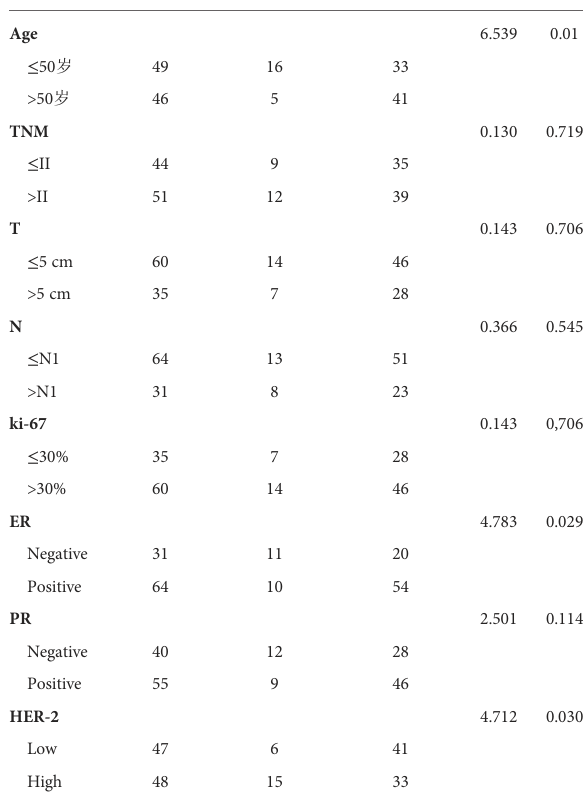
TABLE 3 Relationships between SII and clinicopathological characteristics.